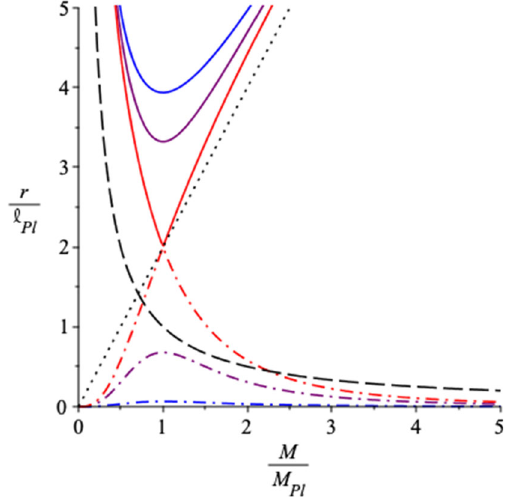
Fig. 8 The outer (solid) and inner (dash-dot) horizons for the GUP- Kerr black hole with β = 2 and n = 1 (blue), 3 (purple) and 4 (red). The n = 4 curves have a discontinuity at M = M Pl and r = 2 (cid:3) Pl , cor- responding to a phase transition. The dashed line is the Schwarzschild radius and the dotted curve is the Compton wavelength